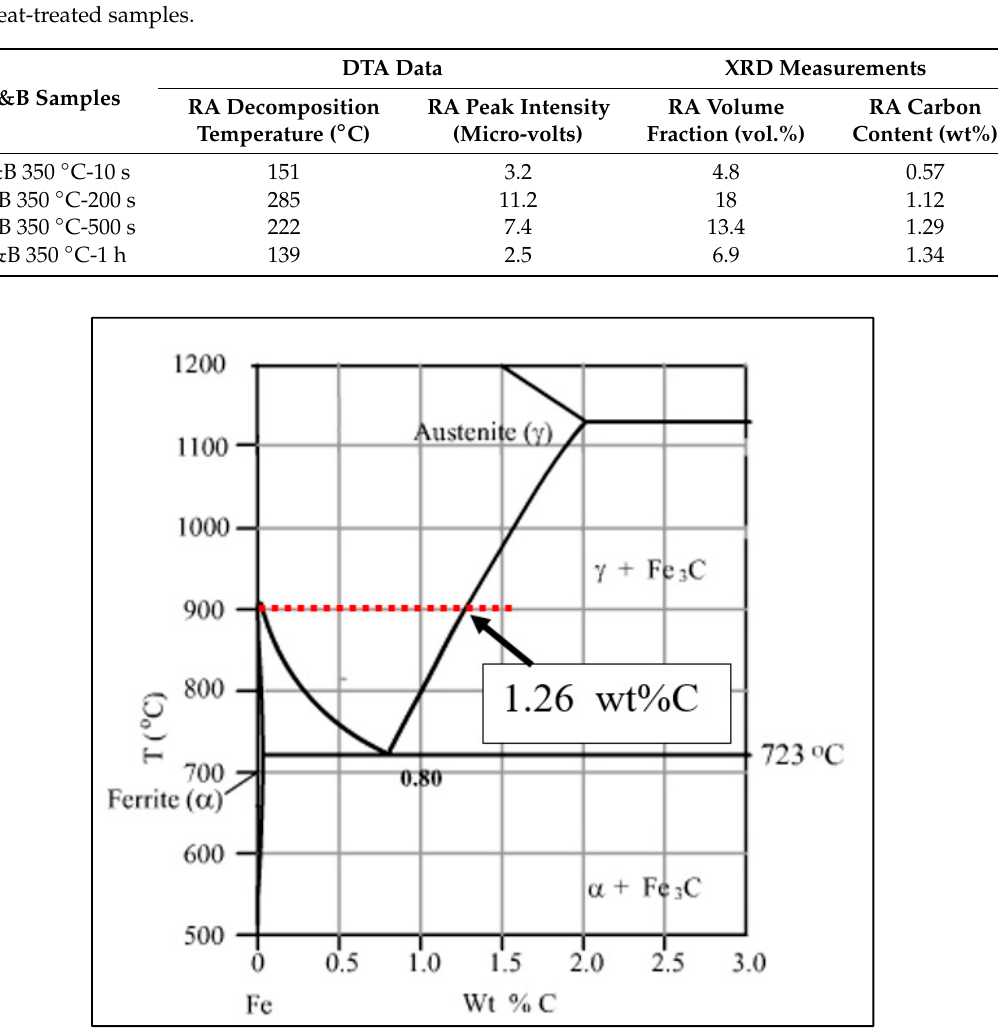
Figure 8. A portion of binary Fe-C equilibrium phase diagram indicating the maximum solubility limit of carbon in austenite is 1.26 wt% at 900 °C.